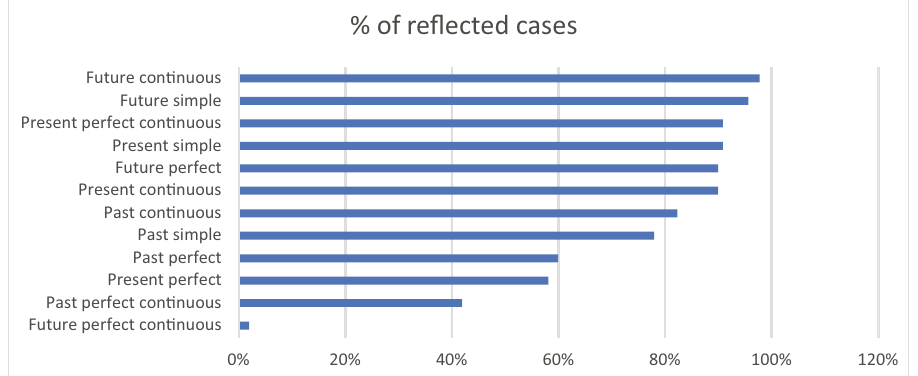
Figure 3: All - engine